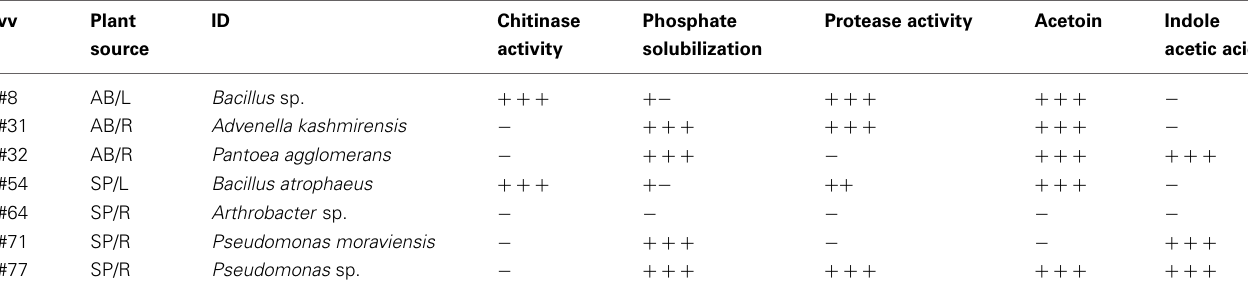
Table 3 | Plant growth promoting properties of the selected endophytes used for plant inoculation studies.